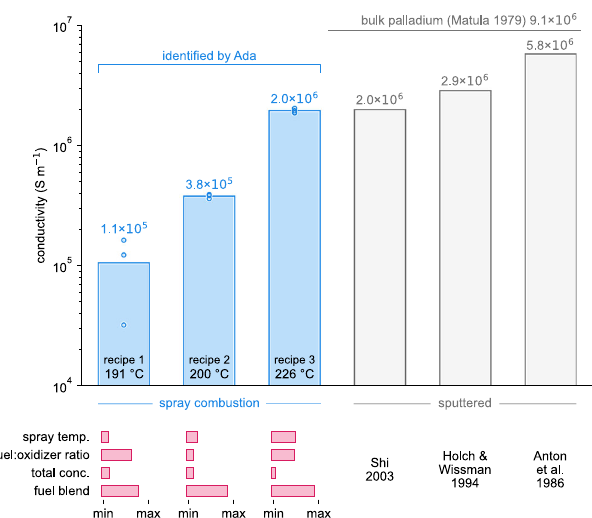
Fig. 6 Comparison between the conductivity of the spray-coated